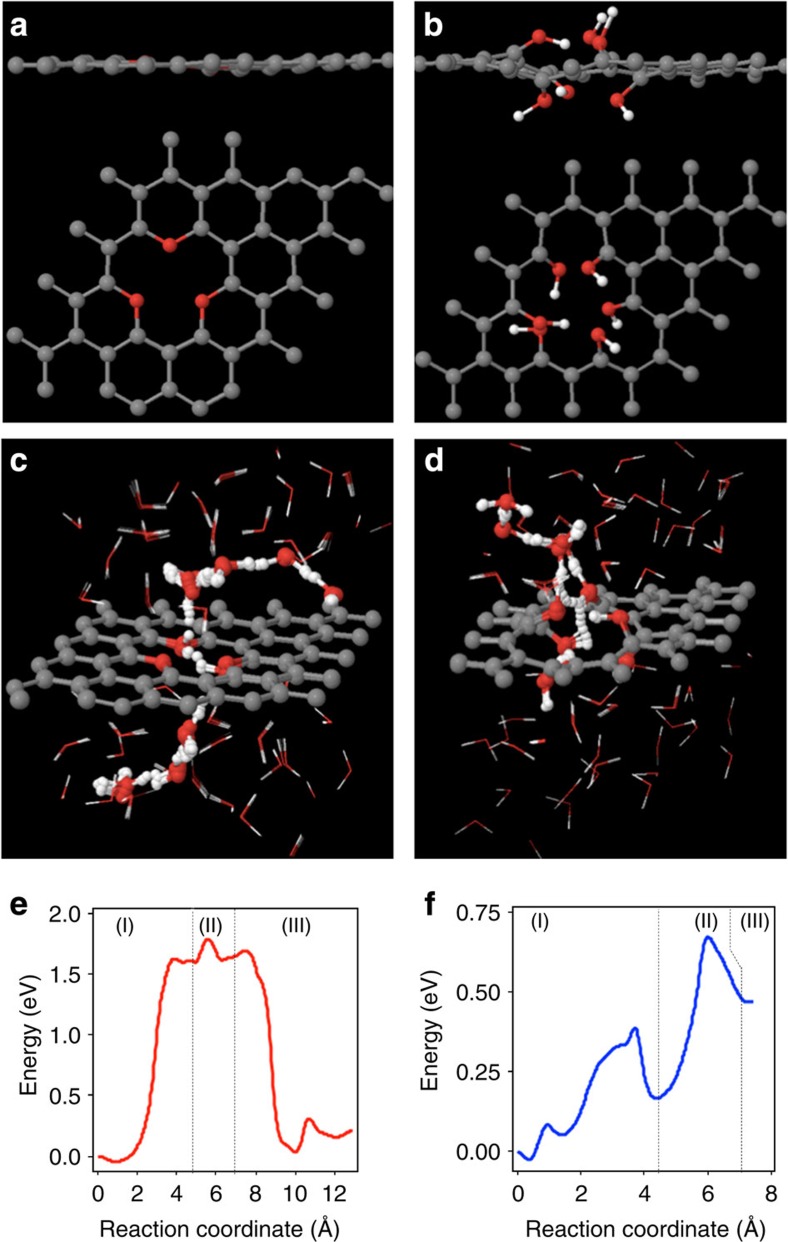
Density functional theory calculations.Side and top views of oxygen- (a) and OH- (b) terminated defect models used in the DFT calculations. Snapshots (c,d) and energetics (e,f) from the nudged elastic band calculations for proton transfer through the oxygen- and OH-terminated defect sites marking (region I) release of proton from H3O+ to oxygen and OH groups, respectively; (region II) relay of proton between oxygen and OH groups, respectively; (region III) release of proton from oxygen and OH groups to H3O+, respectively. Denotations of spheres: grey=carbon; red=oxygen; white=hydrogen atoms.